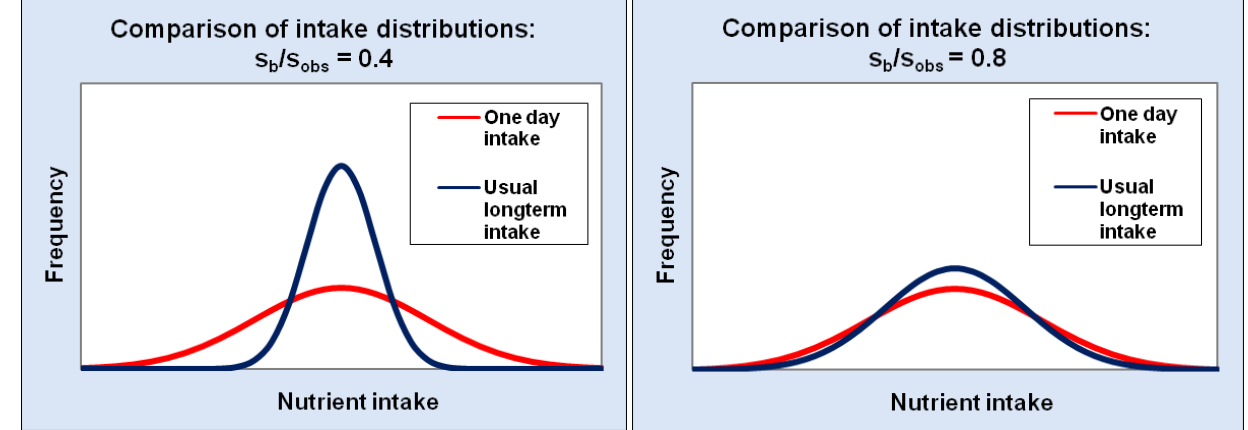
Figure 4. Illustration of the impact of two different between/total ratios (s the spread of an intake distribution estimated from collecting one-day of information from each survey participant to estimate the population distribution of long-term intakes of the same